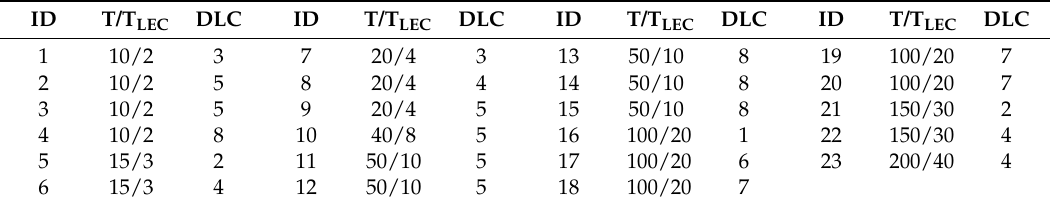
Table A2. PSA message set.